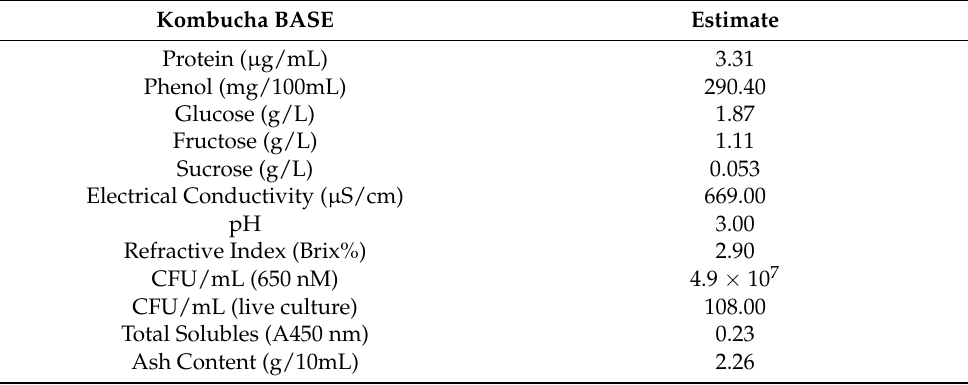
Table 2. Physiochemical properties of